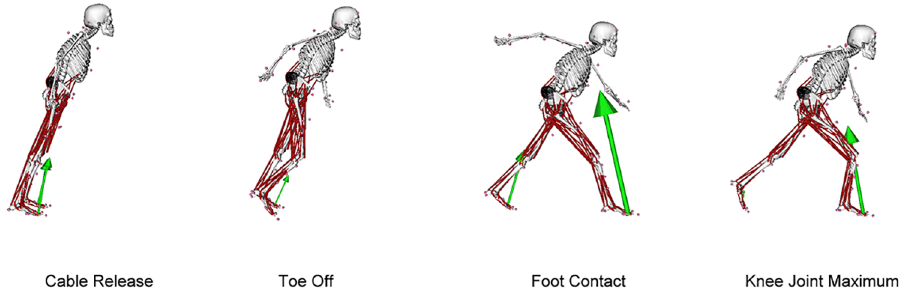
Fig 1. Body configurations at cable release,toe off, foot contact and knee joint maximum during balance recoveryfor a representative participant. The vectors represent resultant groundreactionforces measureunder each foot and the wrap object requiredto maintainerector spinae moment arms is visiblein the regionof the lower back.